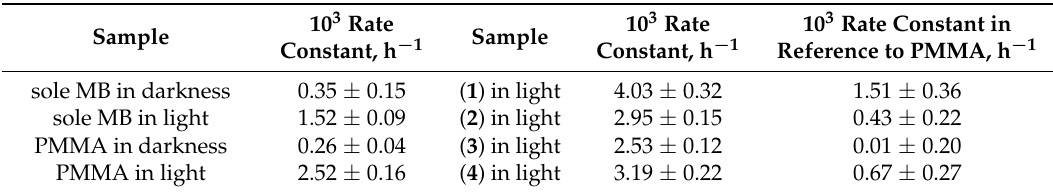
Table 6. Rate constants of MB degradation for sole MB, pure PMMA, and PMMA with addition of the studied materials.